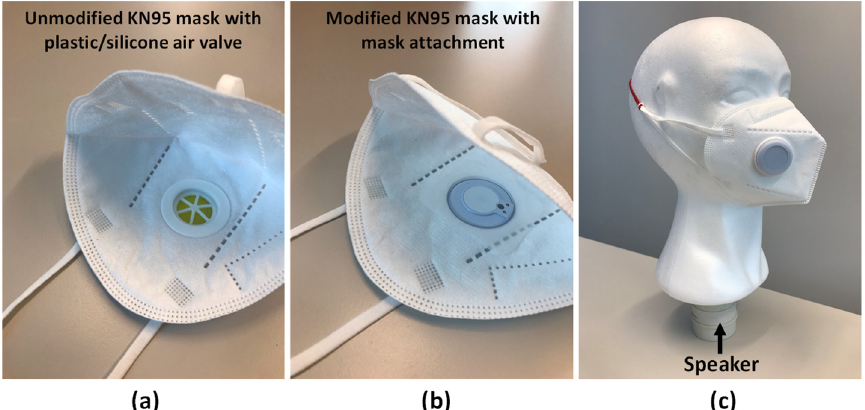
Figure 1. Experimental setup for both the user test and simulated wheeze and normal breath signal through the mannequin for the wheeze detection test. ( a ) The unmodified KN95 mask with a plastic/silicone air valve. ( b ) The modified KN95 mask with a miniature sensor inserted through a silicon patch. ( c ) A speaker was inserted at the bottom of the mannequin to mimic the travel of lung sound through trachea to the face